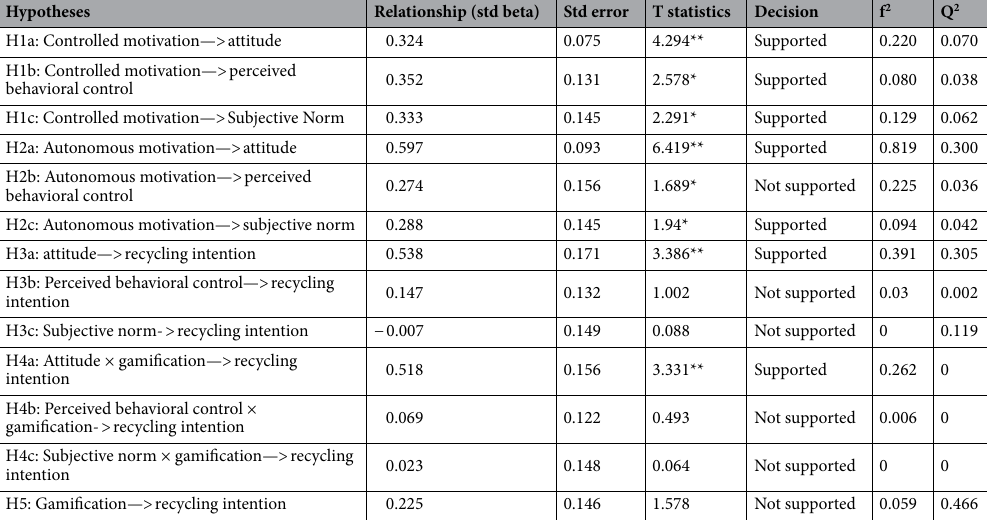
Table 4. Structural estimates (hypothesis testing). Critical t-values **2.58 (p < 0.01), *p < (0.05).